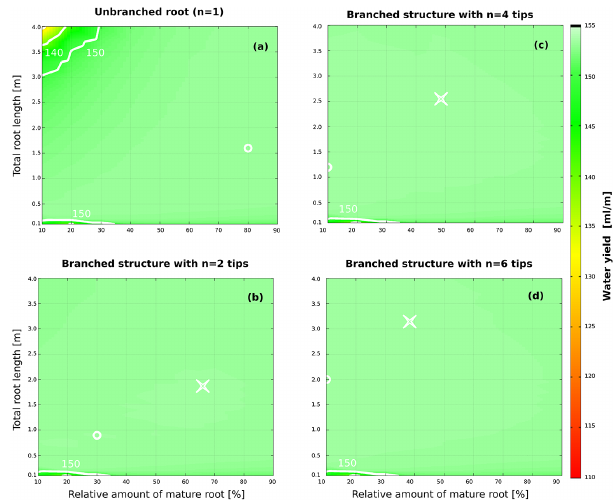
Figure 5. Water yield ˜ v depending on topology and composition of single roots, obtained with the single model. Results are shown for (a) unbranched roots and branched roots (fishbone structures) with (b) two, (c) four and (d) six tips. Root composition is given by total root length ( y axis) and the proportion of mature roots ( x axis). Colours are the same as in Fig. 3 (bottom right). Optimal values of water yield are denoted by white circles. The crosses in figures (b– d) indicate water yield for a root that is the same as the optimal unbranched heterogeneous root from (a) except for containing one, three and five more equal young root tips,